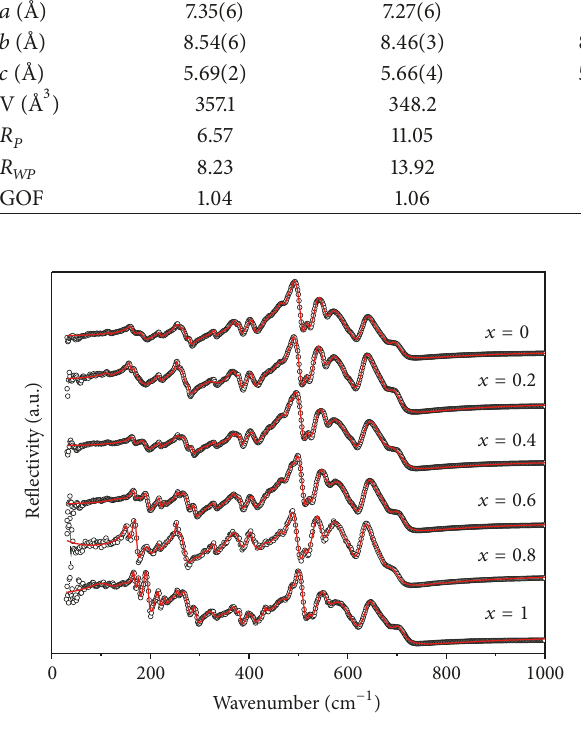
Figure 3: Infrared reflectivity of Gd 1−𝑥 Y 𝑥 Mn 2 O 5 ( 𝑥 = 0 , 0.2, 0.4, 0.6, 0.8, and 1) at room temperature. The black open circle shows the experimental curve and the red line shows the fitted data. The spectra are vertically shifted for